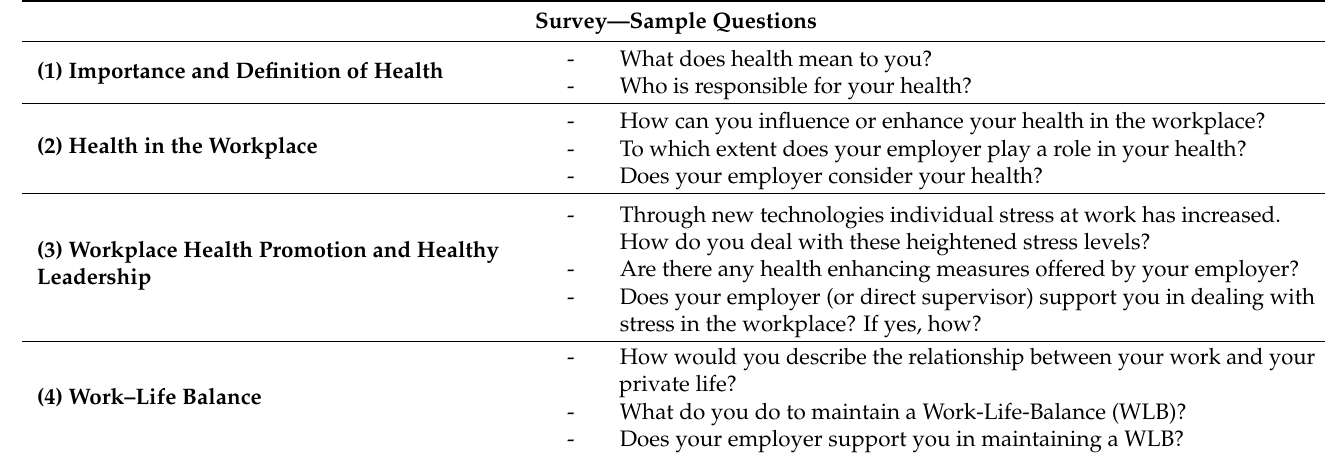
Table A1. Interview guideline with sample questions for each section (note: original items have been translated). Survey—Sample Questions